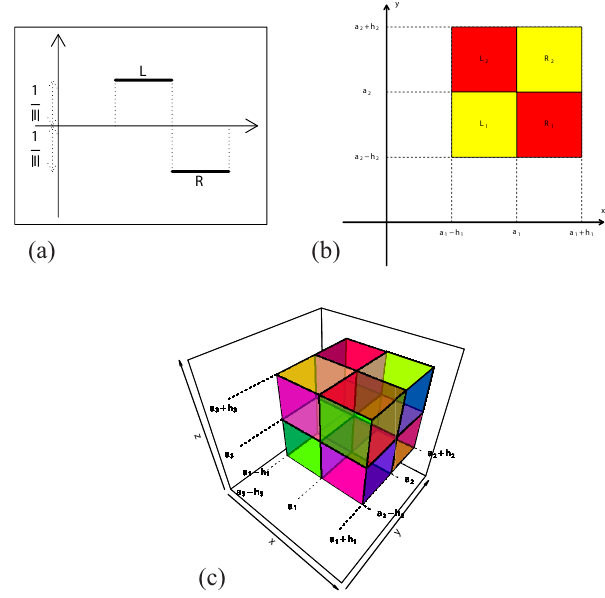
Figure 1: Illustration of the special atom, for = n 1 in ( a ) , = n 2 in ( b ) , and = n 3 in ( c )